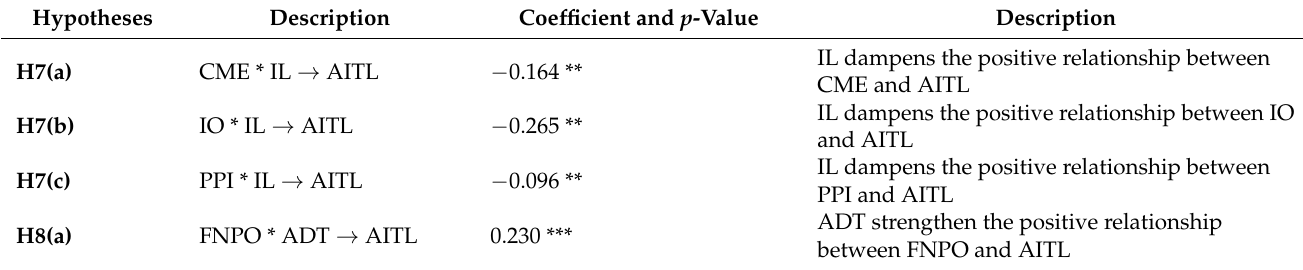
Table A8. Description and outcome of the proposed moderating